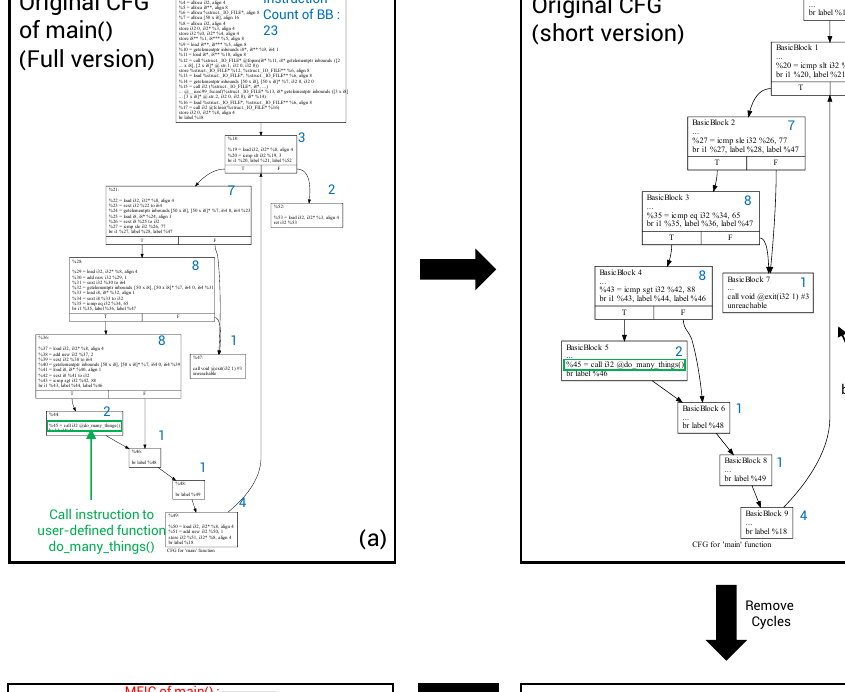
Figure 5 is an example of our process from CFG extraction to MEIC calculation that is applied to the motivating example in Figure 3. Figure 5a is the original CFG obtained using the LLVM framework, and the instructions of the program are described in each basic block. The instruction counts of each basic block can be simply calculated by counting the number of instructions. The calculated instruction count is represented by a blue number to the right of each basic block. The instruction which is marked with a green square is a call instruction that calls user-defined function do_many_things(). This call instruction should be considered when calculating MEIC later.